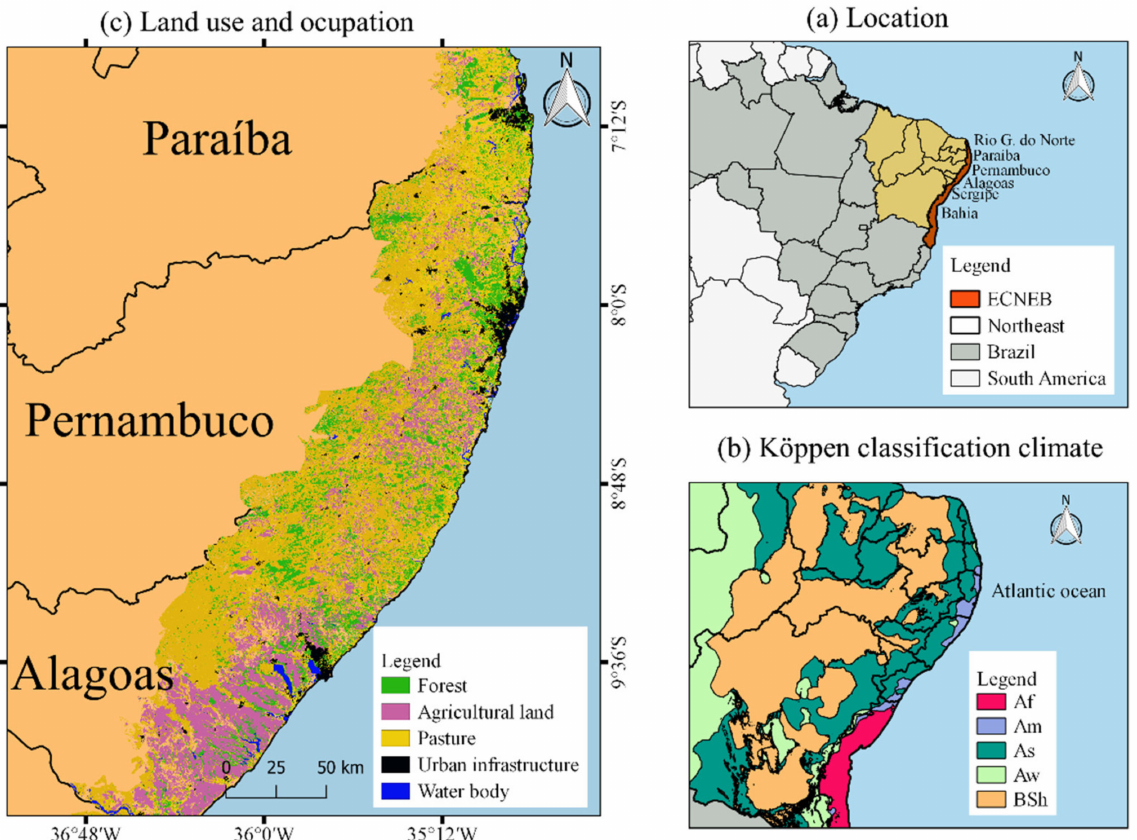
Figure 1. ( a ) Location of the study area, ( b ) Köppen climate classification and ( c ) land use/land cover map on the north coast of the